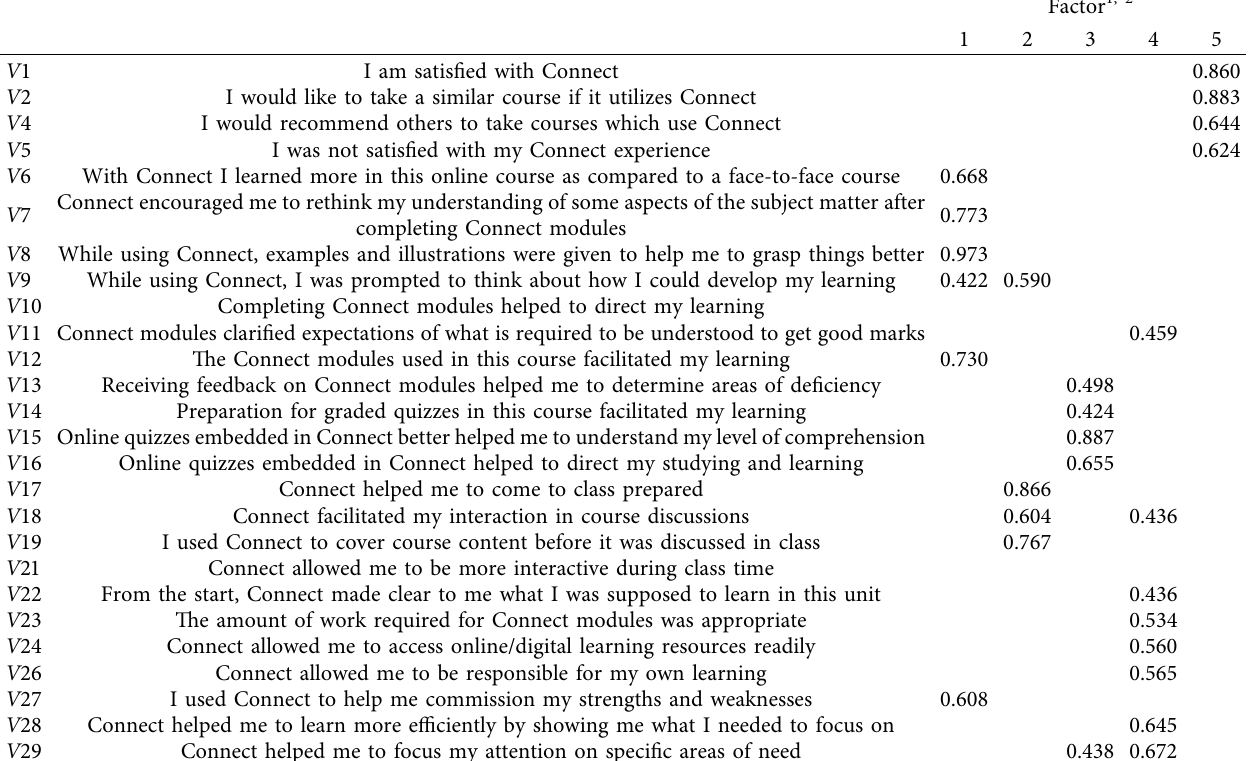
Table 2: The EFA rotated extracted factors with item